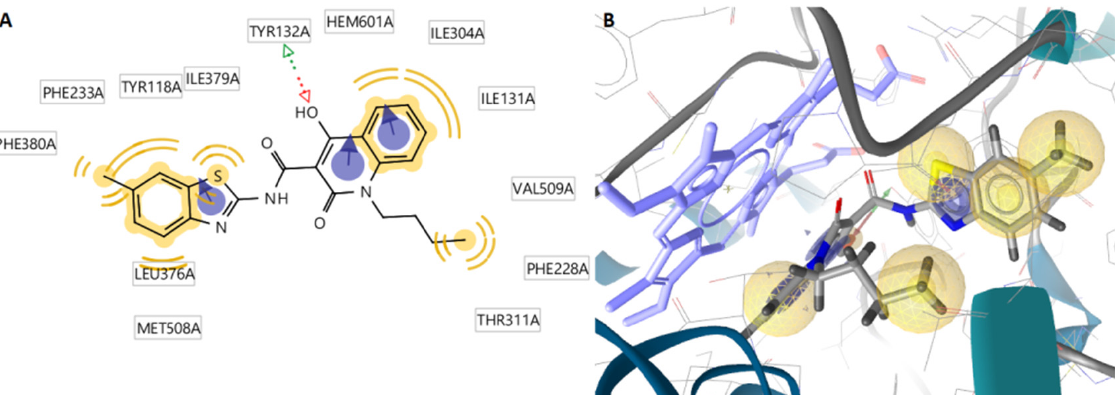
Figure 5. Docked conformation of the most active compound 9 in lanosterol 14 α -demethylase of C . albicans (CYP51 ca ) ( A , B ). Red and green dotted arrows indicate H-bond, blue arrows indicate aromatic interactions, and yellow spheres indicate hydrophobic interactions.